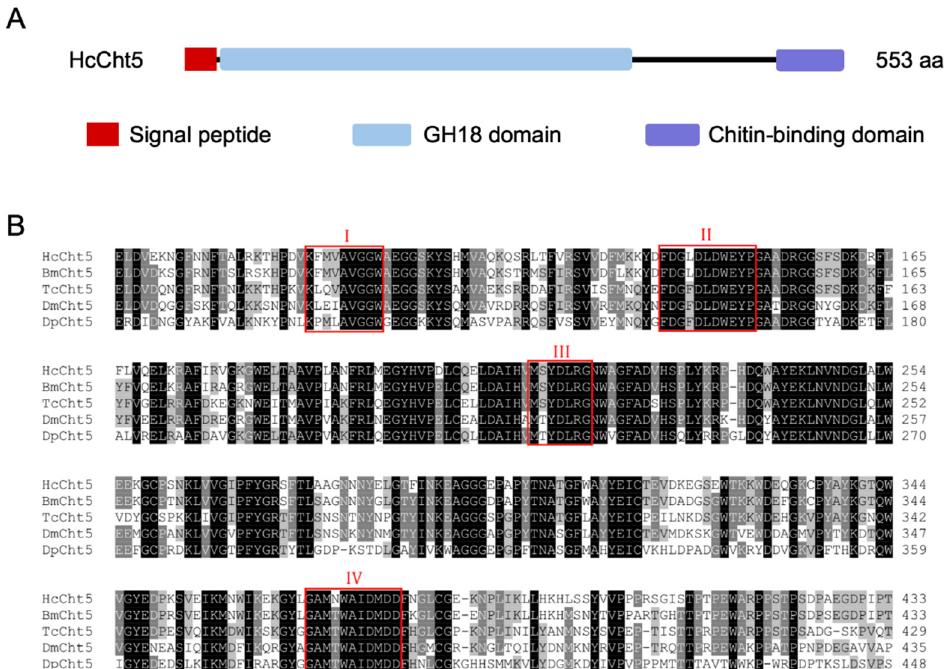
Figure 1. Domain architectures and catalytic motif analysis of H. cunea chitinase (HcCht5). ( A ) Do- main architectures of HcCht5. ( B ) Conserved domains in the glycoside hydrolase family 18 (GH18) of HcCht5 and four other group I chitinases (BmCht5, TcCht5, DmCht5, and DpCht5). The conserved and similar amino acid residues are labeled with black (100% identity) and gray (60–80% identity) backgrounds, respectively. Red-boxed regions are the four conserved motifs (I–IV) represented by the sequences KXXXAVGGW, FDGXDLDWEYP, MXYDLRG, and GAMXWAIDMDD, where X is a nonspecific amino acid. Four insect chitinases belonging to chitinase group I (BmCht5, TcCht5, DmCht5, and DpCht5) were used for catalytic motif analysis. Their GenBank accession numbers are listed in Table S2.